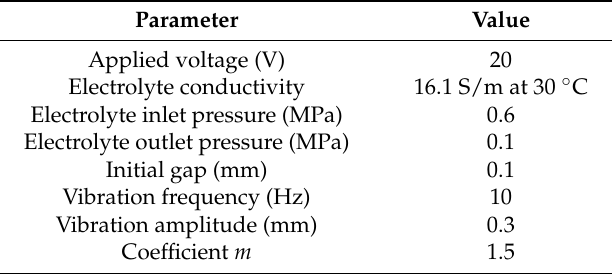
Table 1. Parameter values used in calculations.